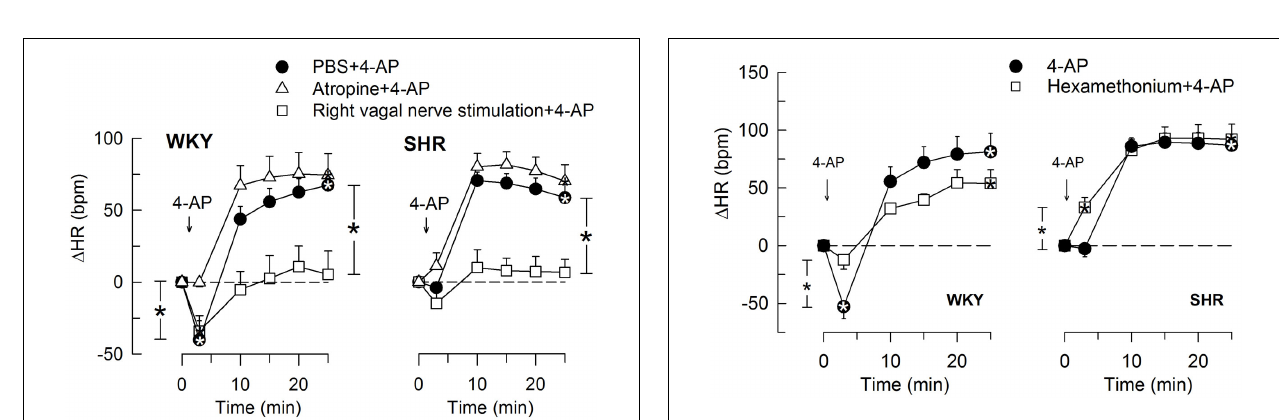
FIGURE 3 |The HR-response to 4-AP after pre-treatment with the mAChR antagonist atropine or electrical stimulation of the right, efferent vagal nerve. After curve evaluation, significant responses (* within symbol) and group differences at HR nadir (brackets left of curves) and at 25min (brackets right of curves) were located as indicated. Atropine had little effect on the HR baseline, whereas vagal stimulation greatly reduced HR in both strains ( Table 2 ). * – P < 0.025.